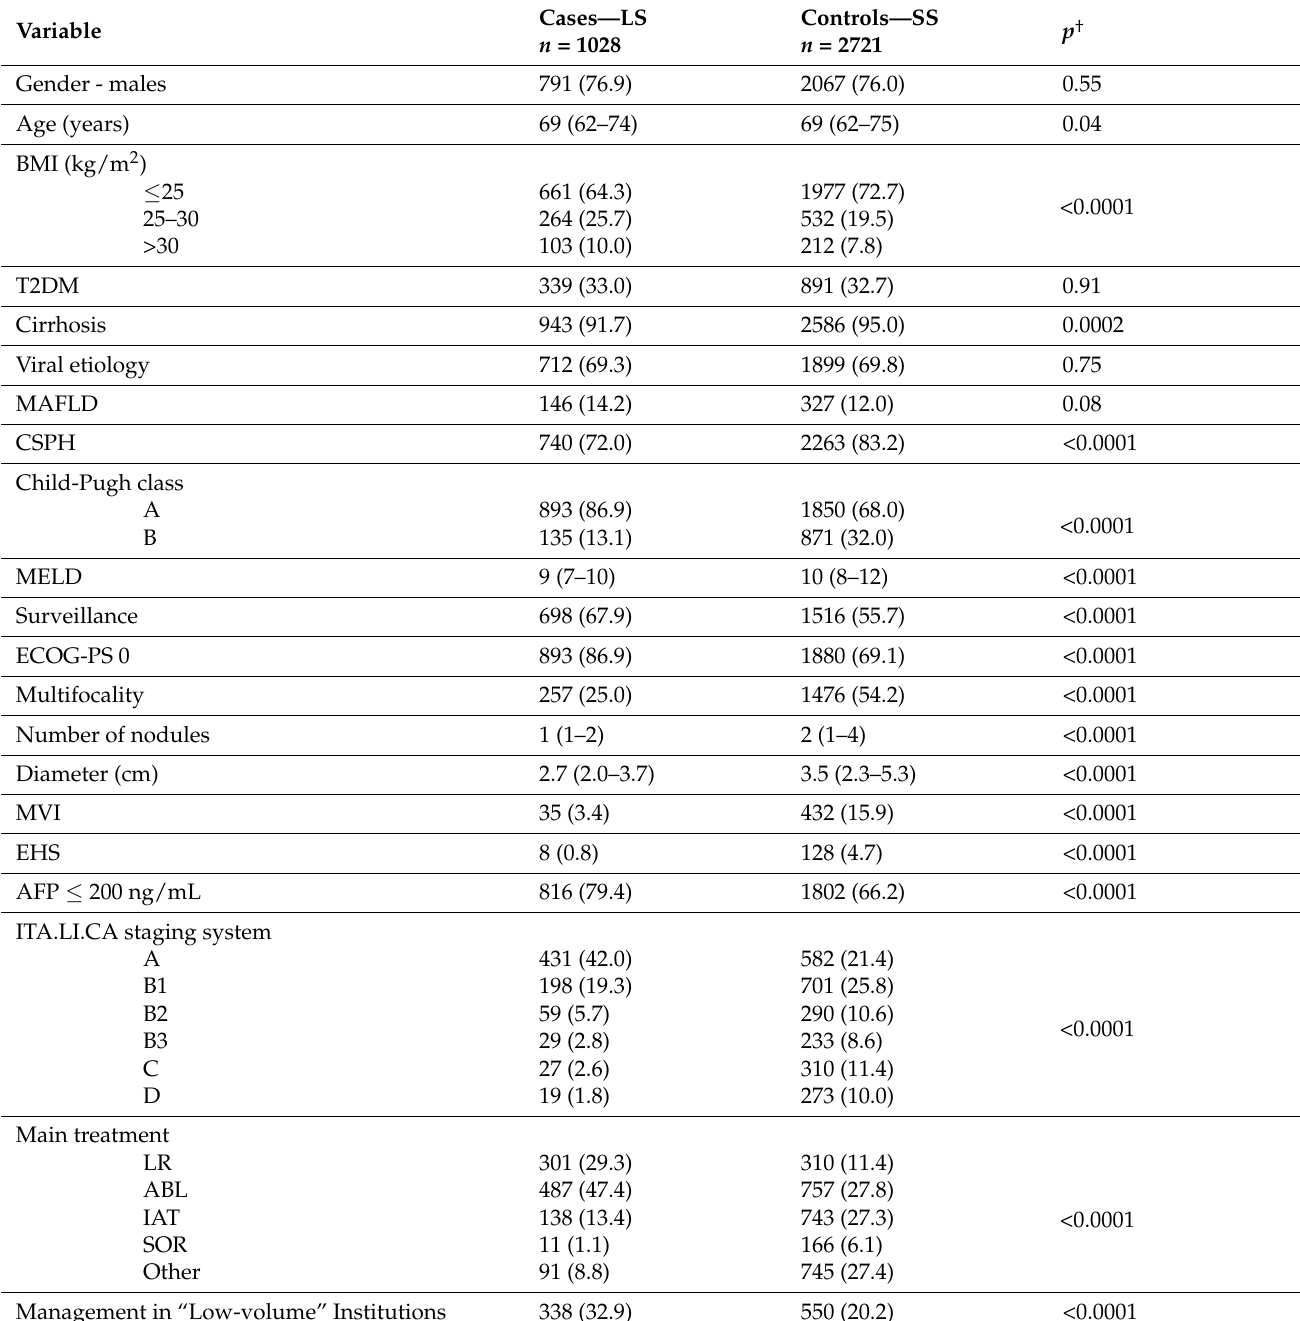
Table 1. Baseline characteristics of cases (long-term survivors—LS) and controls (short-term